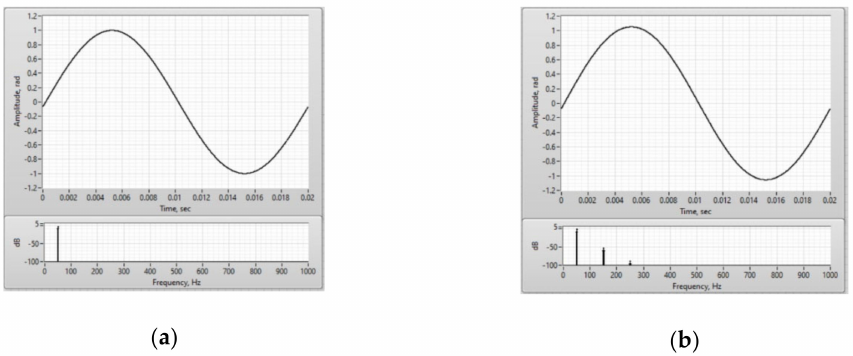
Figure 17. Demodulated current signal and its spectrum. The angle of polarization mismatch at point 8 is: ( a ) 0 ◦ ; ( b ) 10 ◦ .